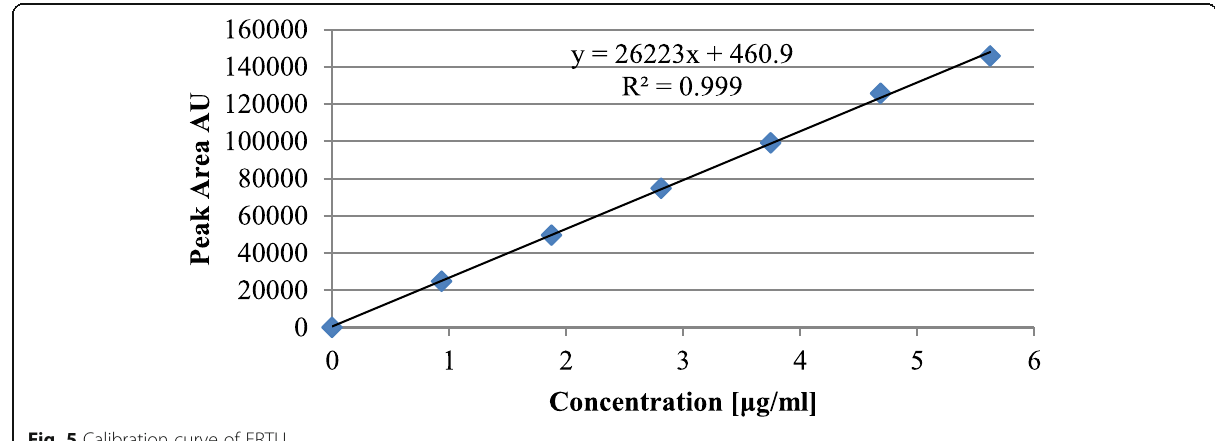
Fig. 5 Calibration curve of